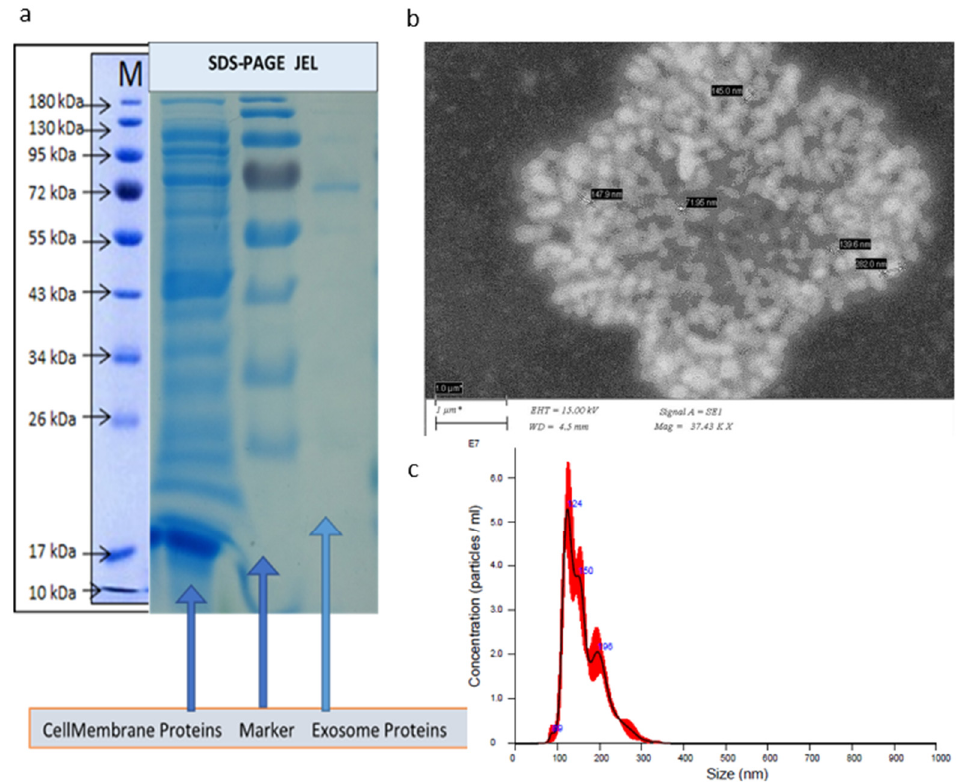
Figure 1. ( a ) SDS-PAGE gel results recorded for surface proteins of the IDC-derived exosomes displayed a higher molecular weight (MW) value of 72 kDa. The MW of membrane proteins varied between 10 kDa and 180 kDa; ( b ) an SEM image of the IDC-derived exosomes; ( c ) NTA data showing the size distribution of IDC-derived exosomes. *: Video S1 and Figure S1.